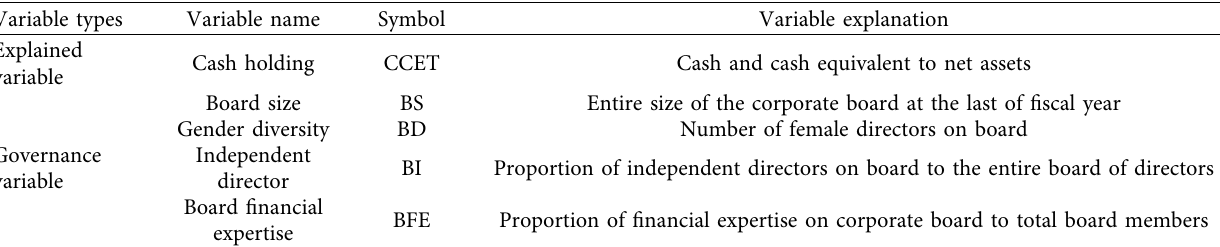
Table 7: List of